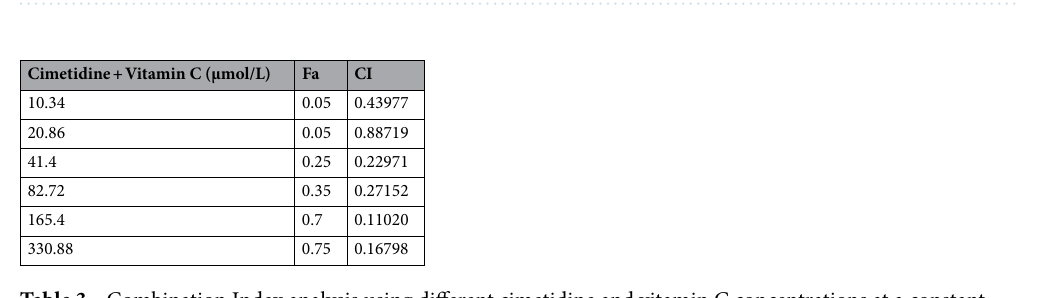
Table 3. Combination Index analysis using different cimetidine and vitamin C concentrations at a constant ratio (1:1). Fa fraction affected and CI combination index.